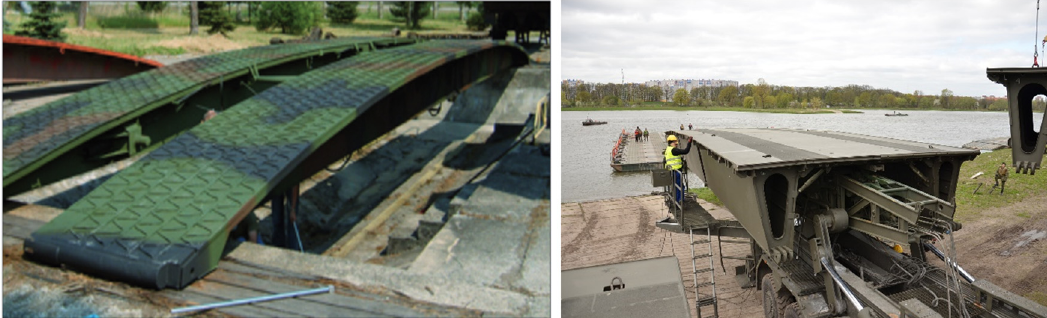
Figure 2: Types of spans: the BLG - 67 [ 11 ] with treadways on the left and the MS - 40 span with no gaps between